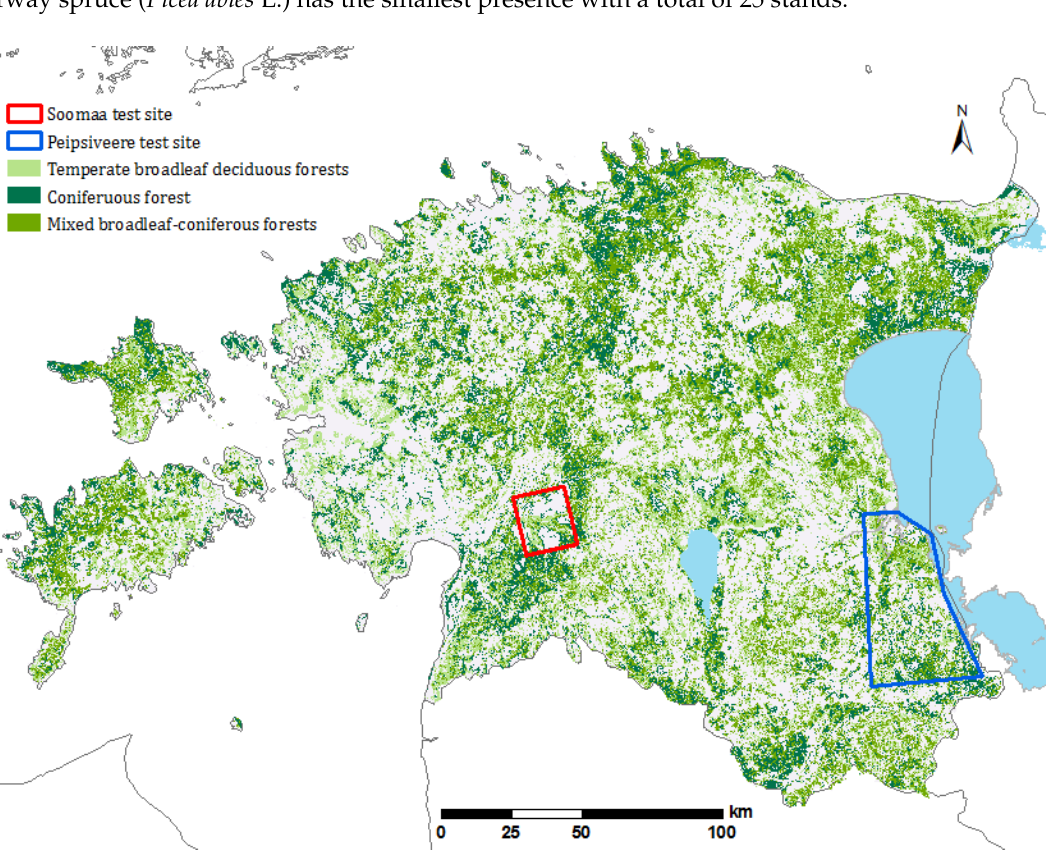
Figure 2. Locations of the Soomaa and Peipsiveere test sites in southern Estonia. Forest data are divided into three classes according to the forest